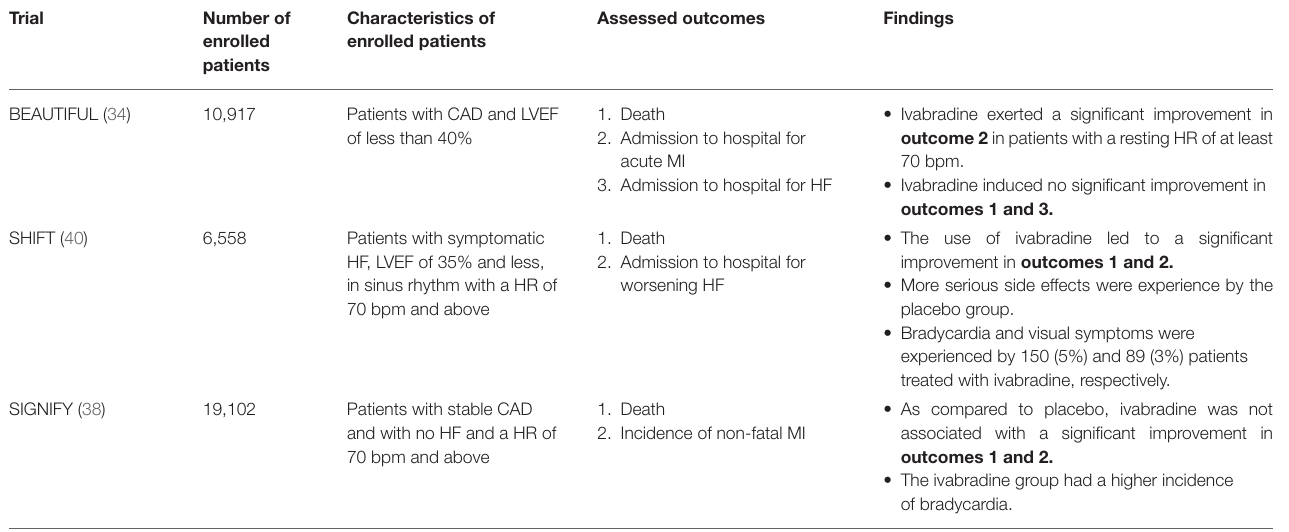
TABLE 4 | A comprehensive comparison of the adult studies (BEAUTIFUL, SHIFT, and SIGNIFY